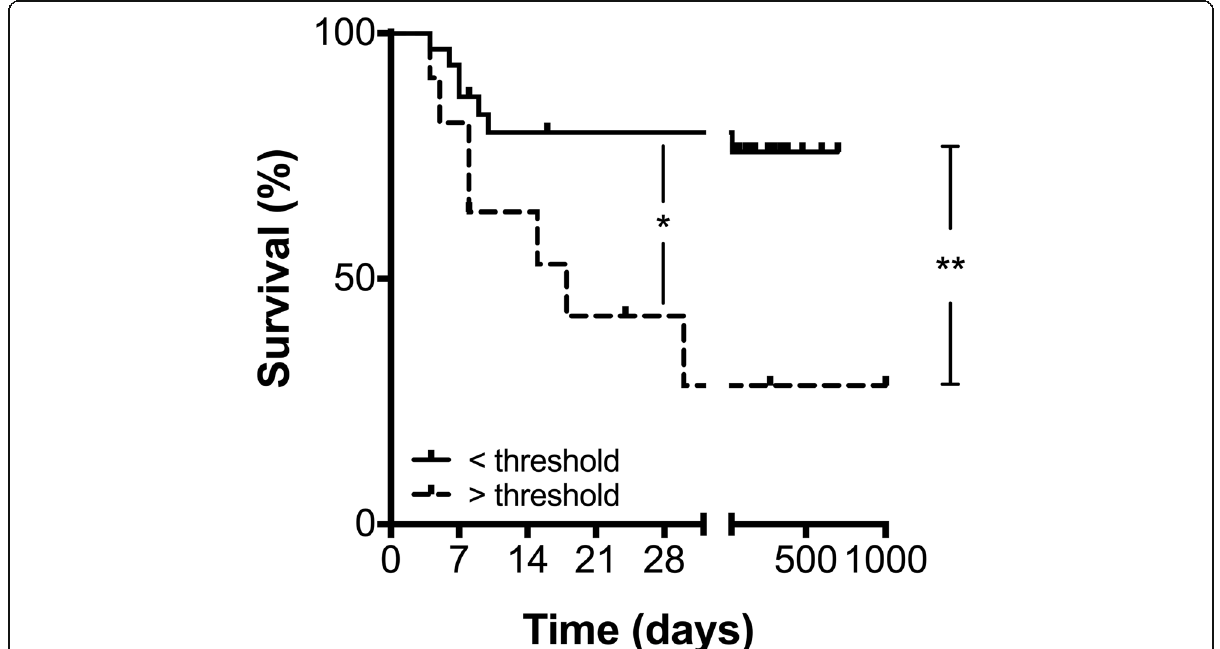
Fig. 4 Circulating fibrocyte concentration as predictors of mortality in subjects with ARDS. Kaplan-Meier survival analysis of subjects with ARDS, separated by peak circulating activated fibrocyte concentration threshold value of 4.8 × 10 6 cells/mL. Of the 42 subjects with ARDS, 9 subjects had values above and 33 subjects had values below the threshold. *, p = 0.028 at day 28 and **, p = 0.009 for the entire follow-up period by Log-rank